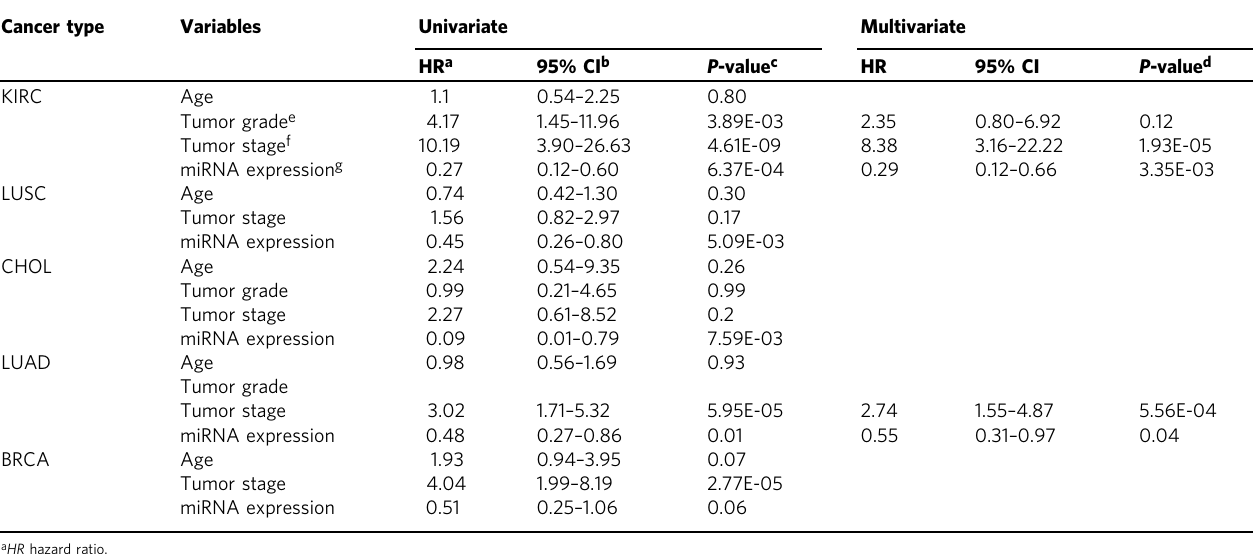
Table 1 Analysis of 10-year overall survival in patients of diverse TCGA cancer